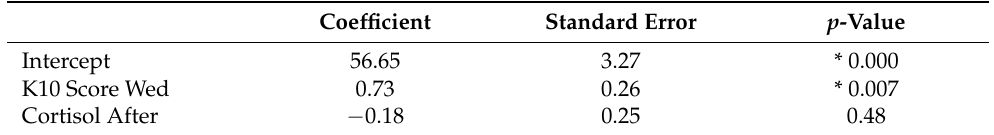
Table 6. Regression results of MASQ Wednesday scores (dependent variable), K10 Wednesday scores, and saliva cortisol levels after exercise (independent variables). * p < 0.1.